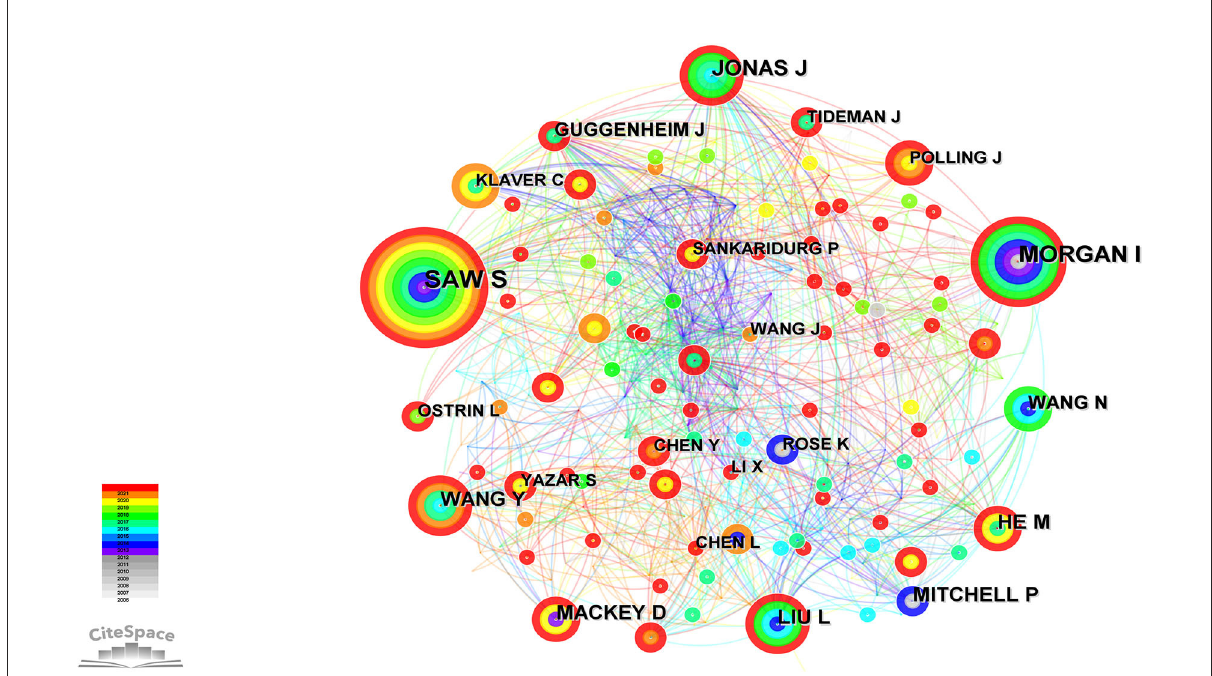
FIGURE6 Authors of studies on the relationship between outdoor activities and myopia from 2006 to 2021.